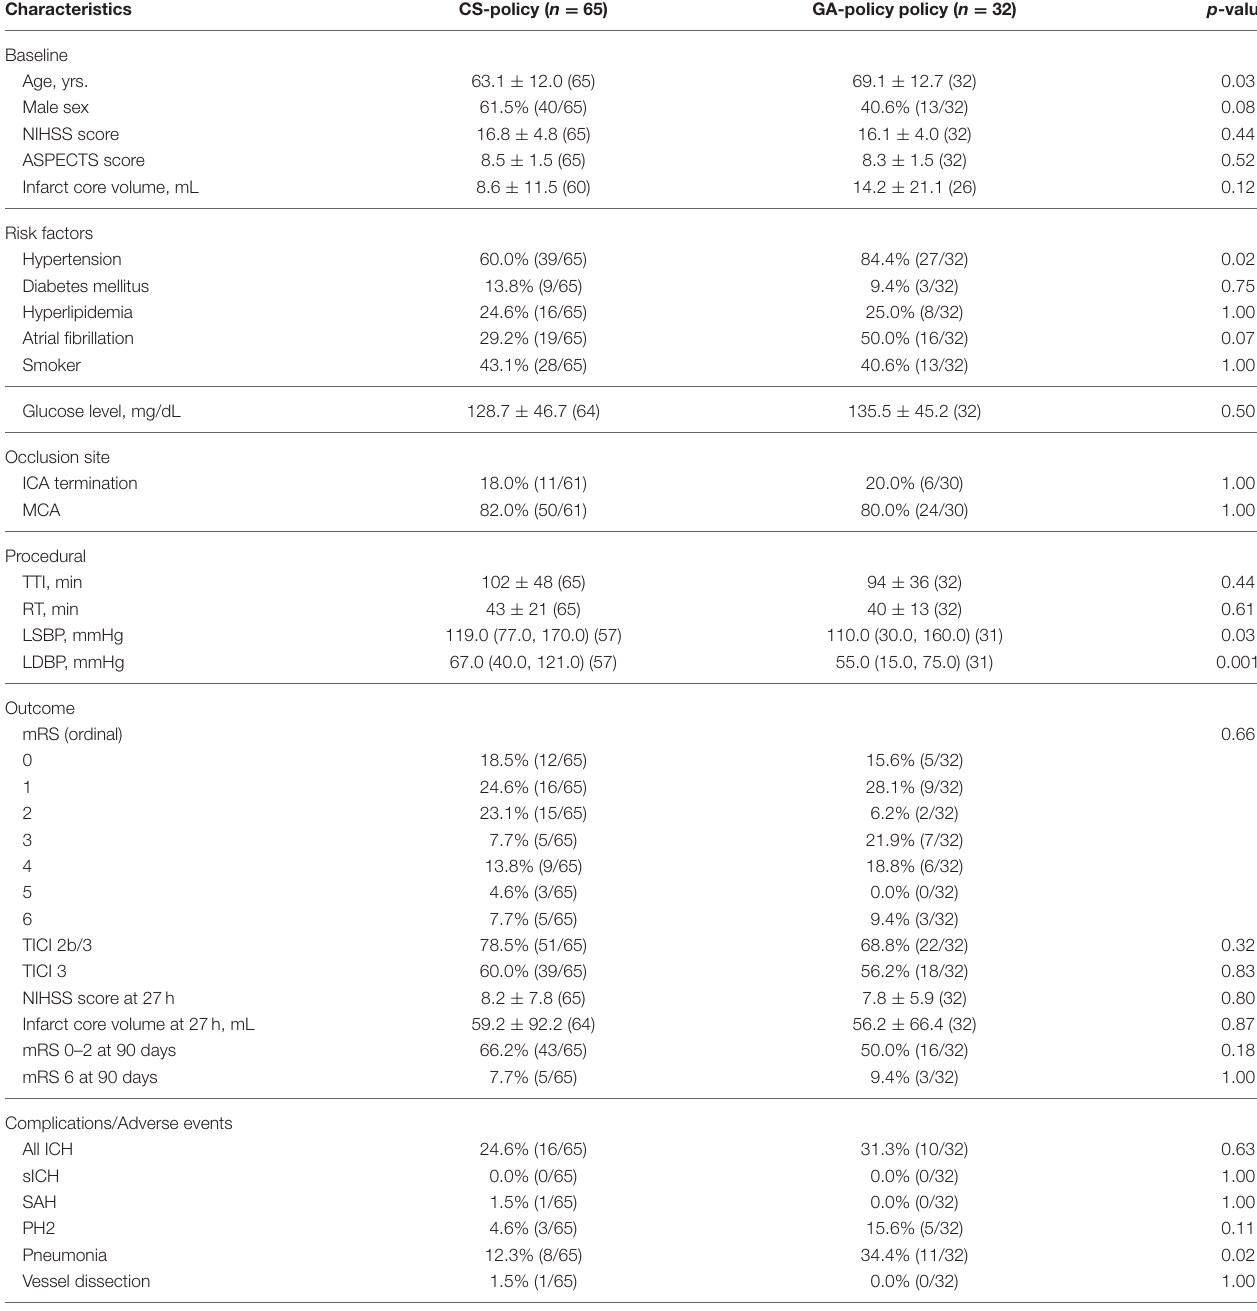
TABLE 1 | Baseline, procedural, safety, and outcome data for the CS-policy and GA-policy groups.